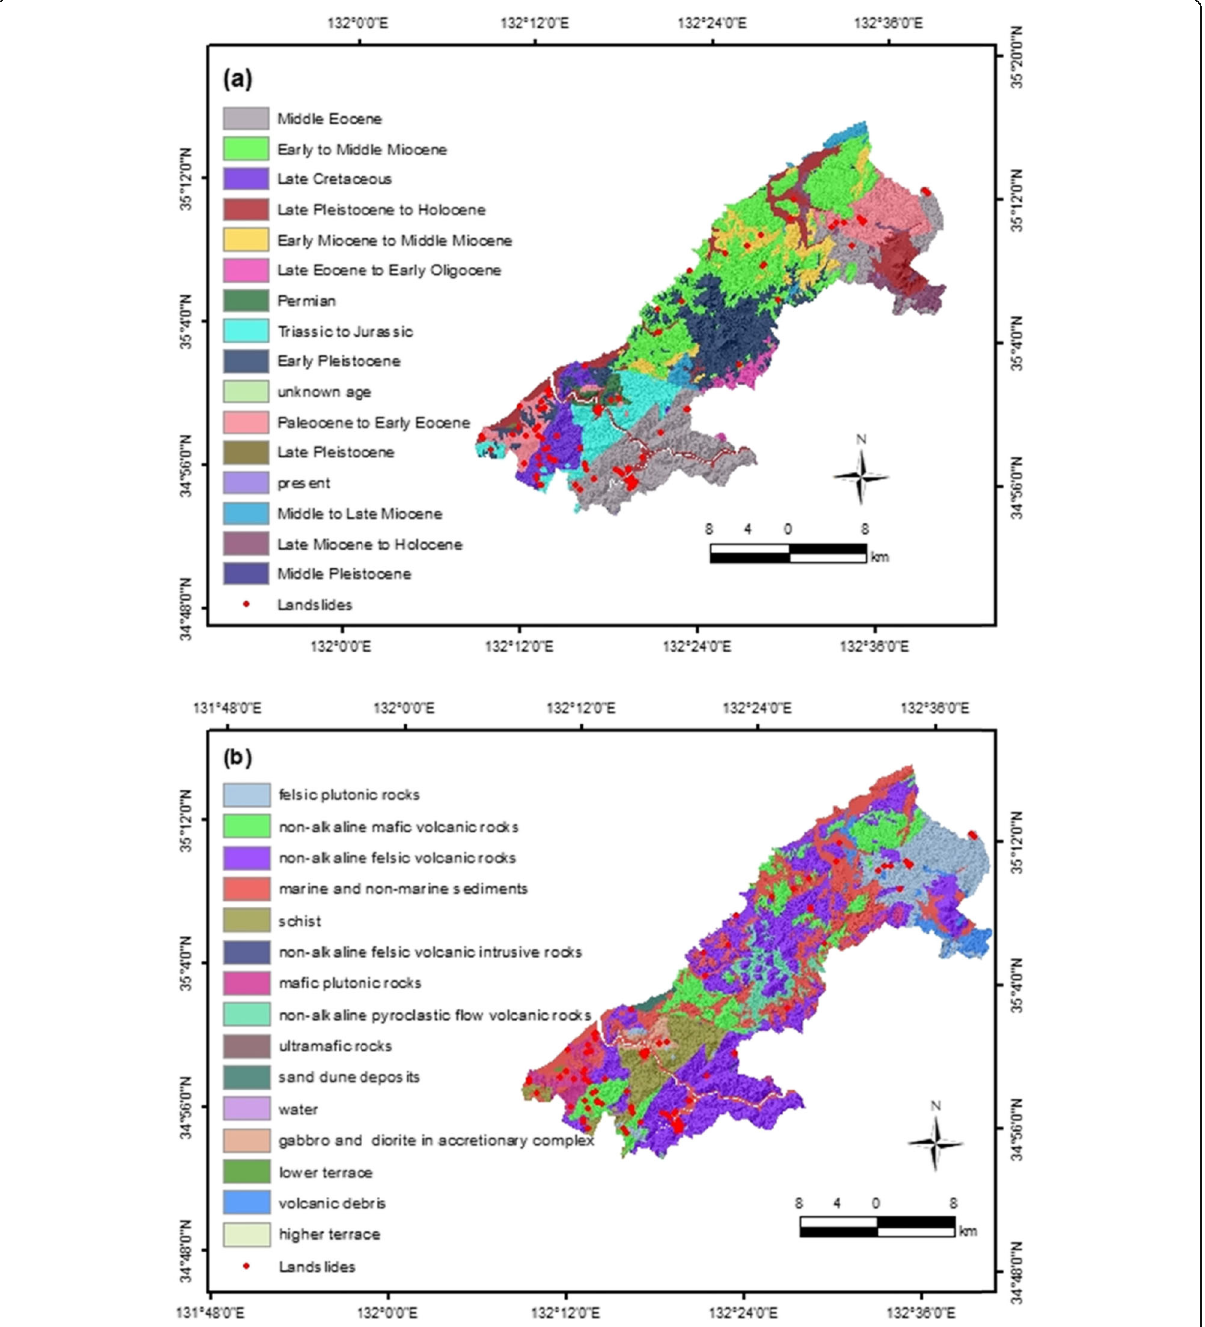
Fig. 5 Thematic maps of geological factors considered in this study: a geological age and b